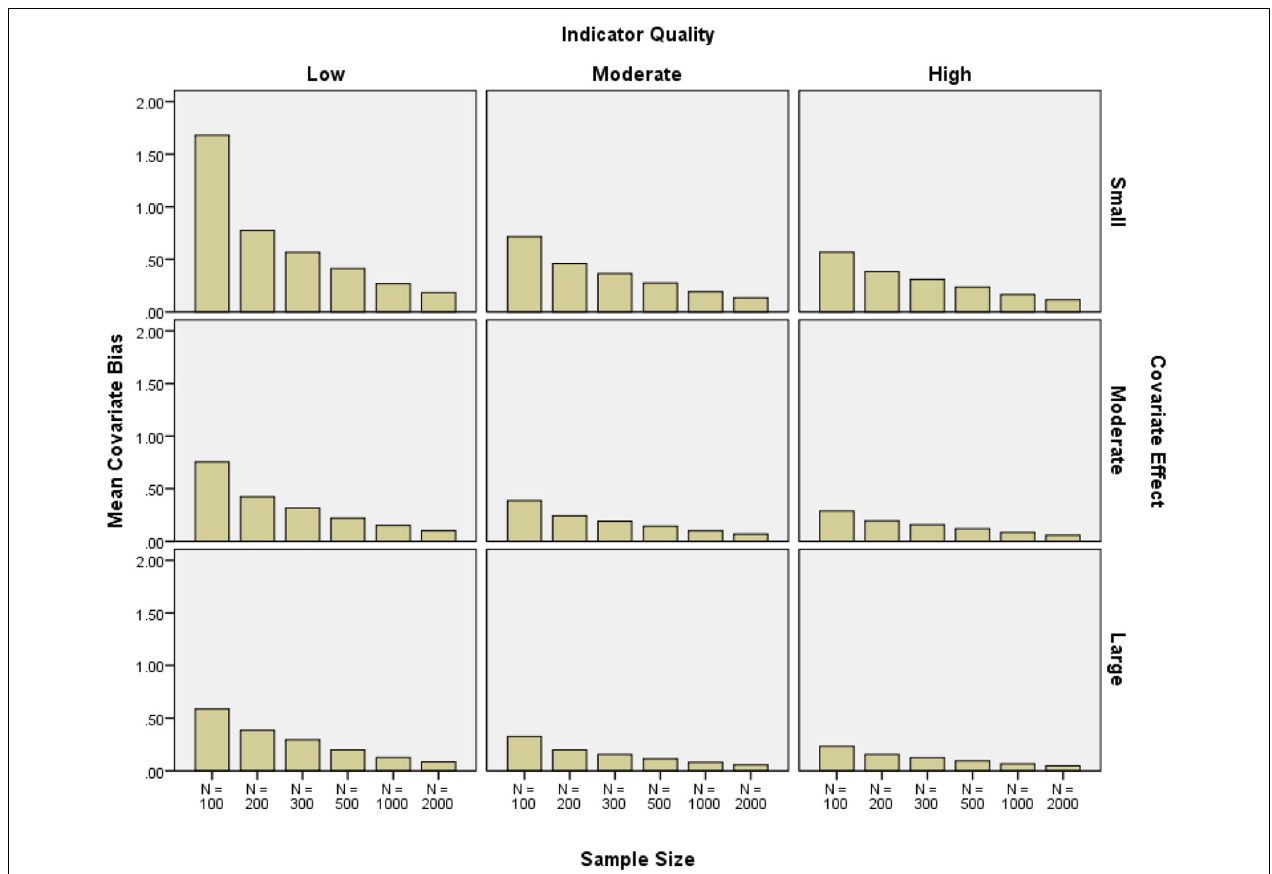
FIGURE 8 | Mean covariate relative bias by indicator quality, covariate effect size, and sample